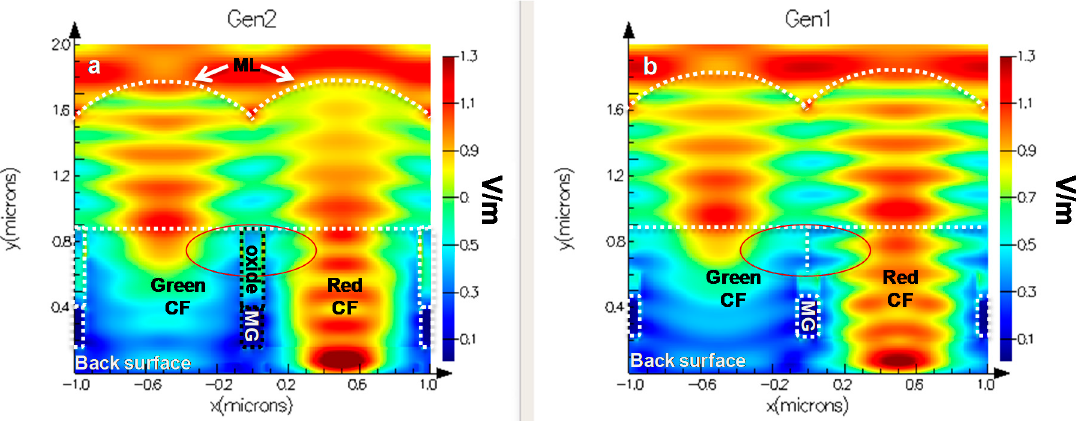
Figure 7. FDTD simulation comparing the light confinement of Gen2 ( left ) and Gen1 ( right ). Simulations used a monochromatic plan wave at, 630 nm TE mode, incident on the Green and Red pixel of each structure. Structure features are labeled and highlighted.